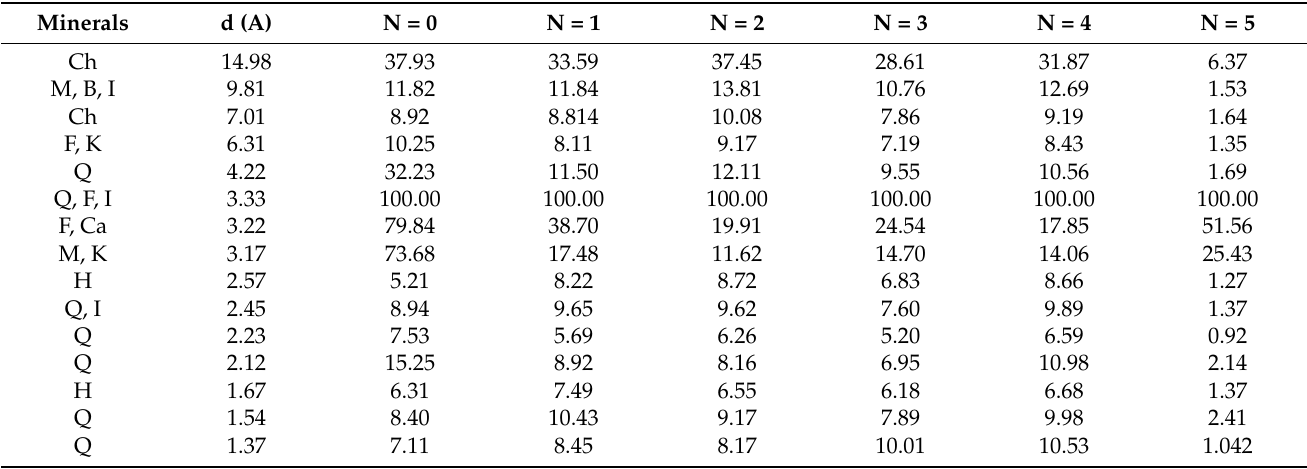
Table 1. Diffraction peak intensity of main minerals of Pisha sandstone